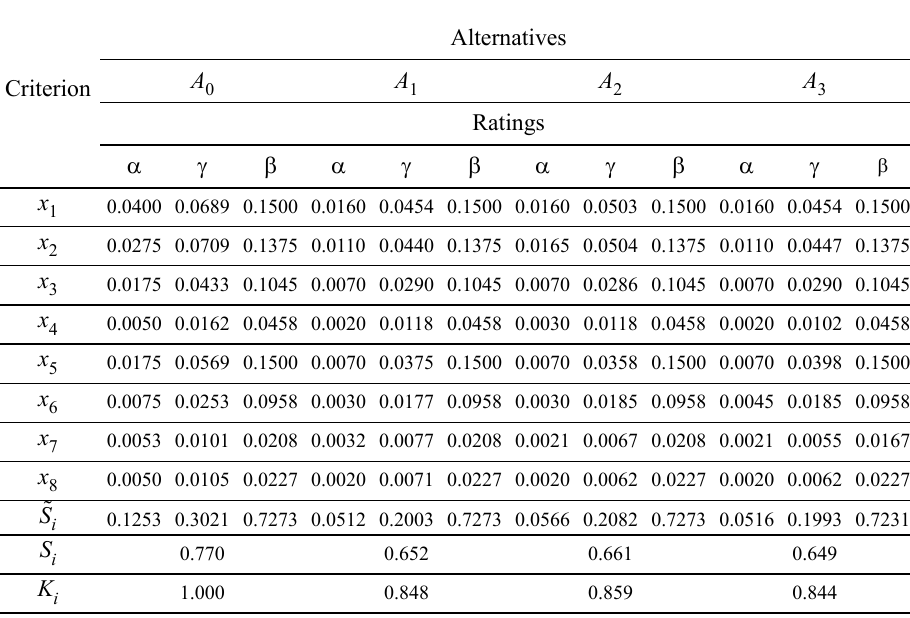
Table 8. The normalized-weighted fuzzy decision making matrix and solution